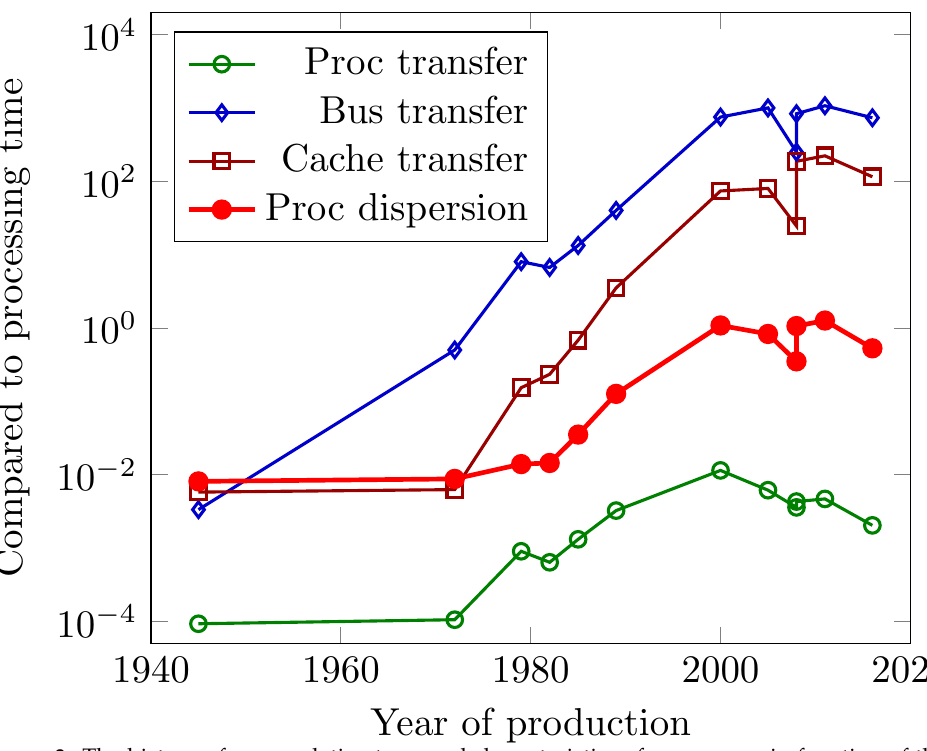
Figure 3. The history of some relative temporal characteristics of processors, in function of their production year. Notice how cramming more transistors in a processor changed their temporal characteristics